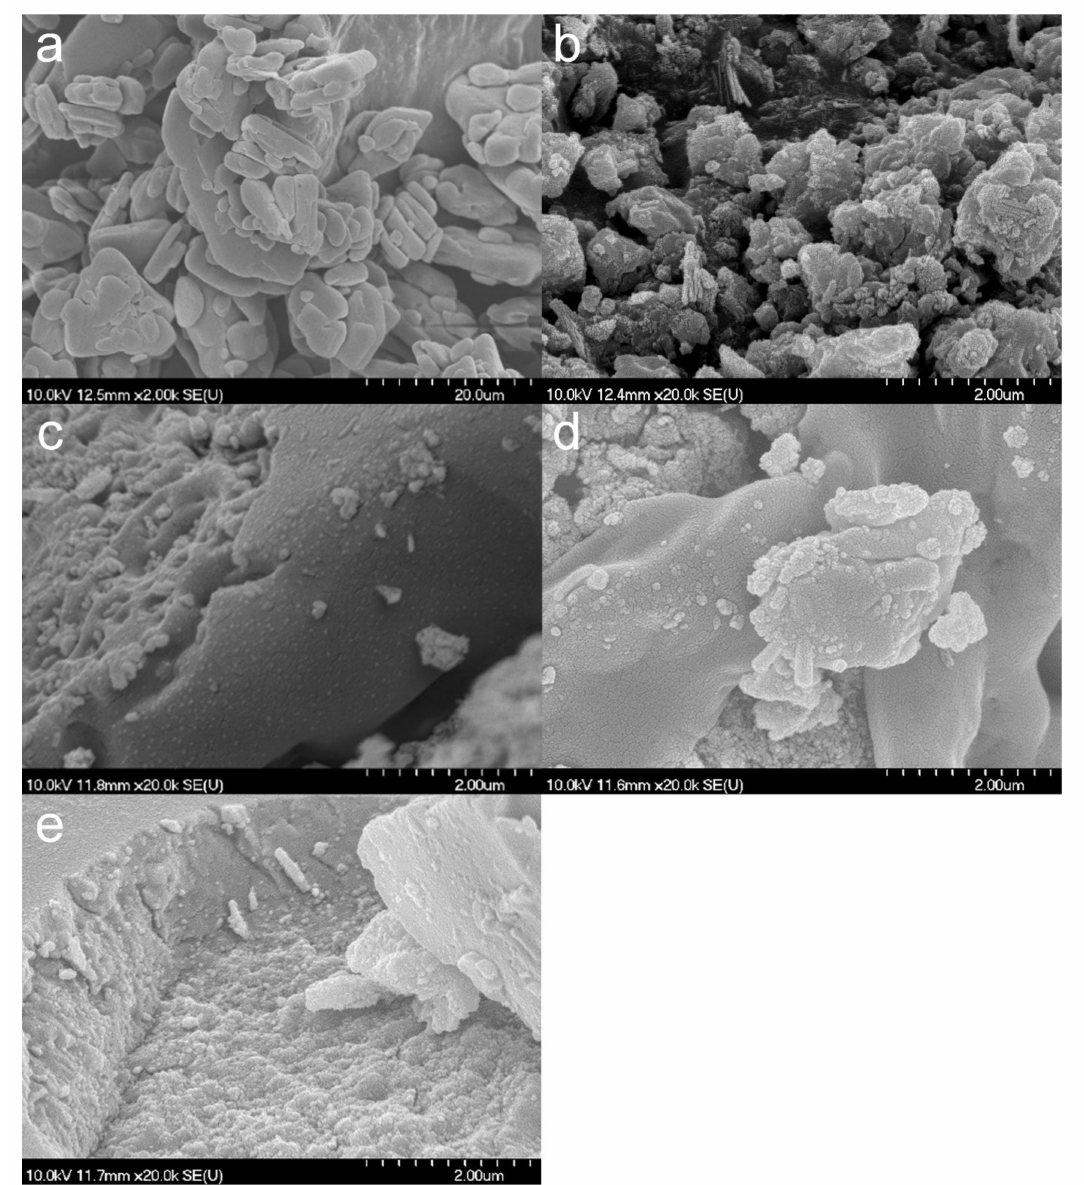
Figure 7. SEM micrographs of HCT ( a ), TiHCT–ethanol ( b ), TiHCT–NaOH ( c ), TiHCT–DMF ( d ), TiHCT–DMSO ( e